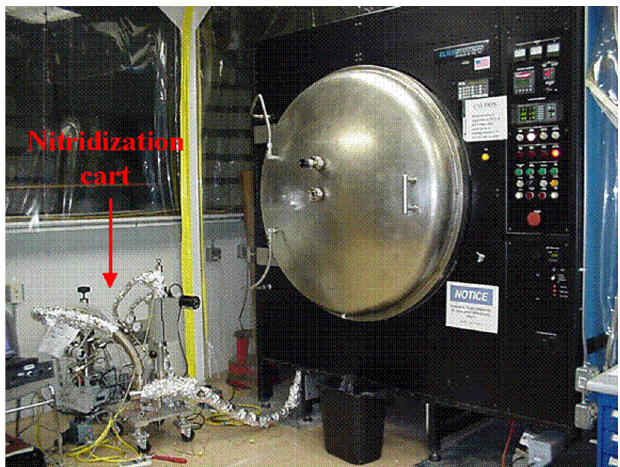
FIG. 11. (Color) Nitridization cart holding a semiconductor grade nitrogen gas bottle, pressure regulator, and needle valve connected to the high-temperature vacuum furnace used for the cavity heat treatments.